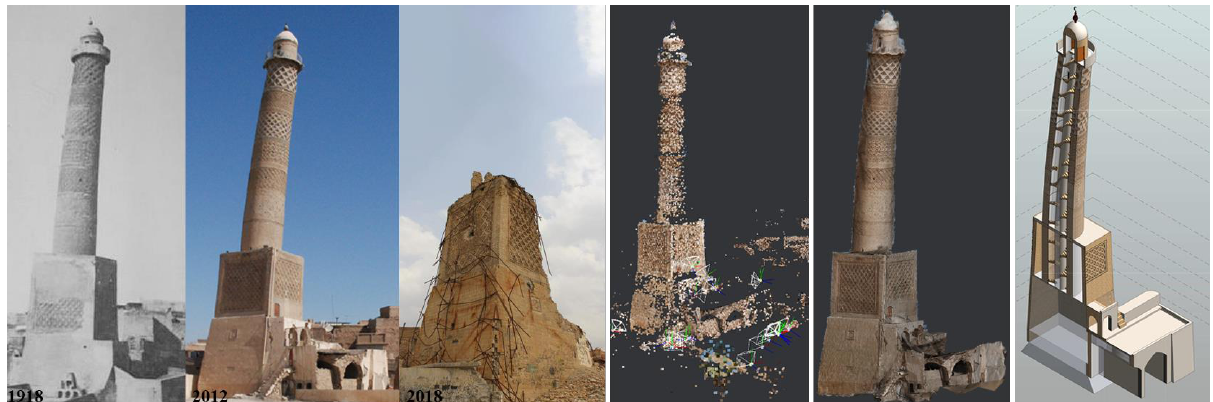
Figure 1. Al-Hadba’ in the past until its destruction (left); an overview of the HBIM process from photogrammetry to model